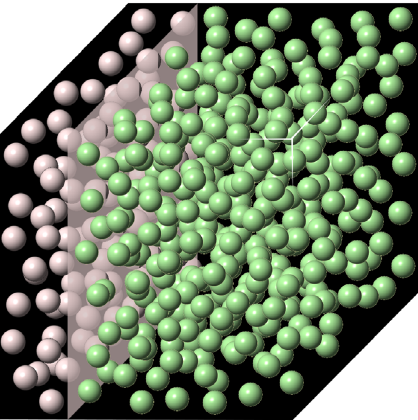
FIG. 2. Pictorial representation of the protocol used to study amorphous interfaces: pink particles on the left of the plane are pinned and green ones on the right are reequilibrated in the presence of this amorphous boundary